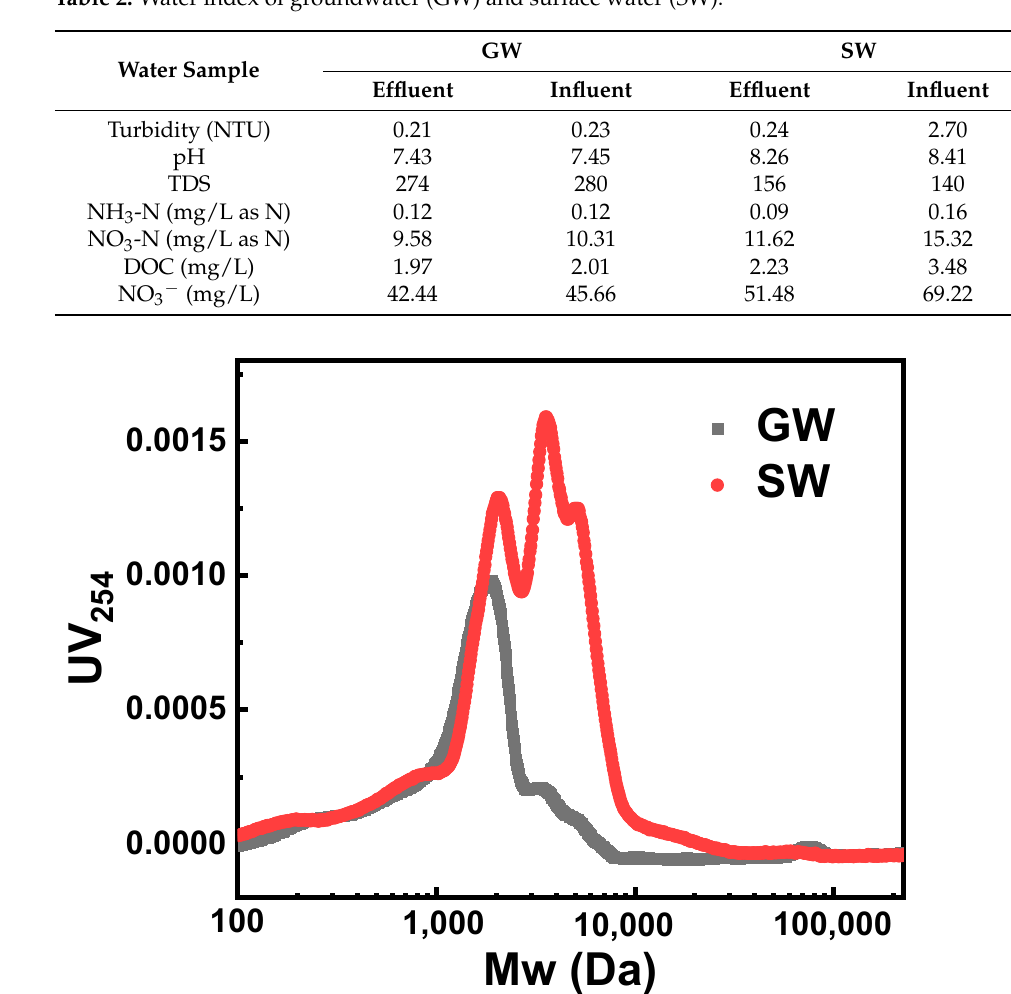
Figure 1. The Mw distribution of the groundwater and surface water.